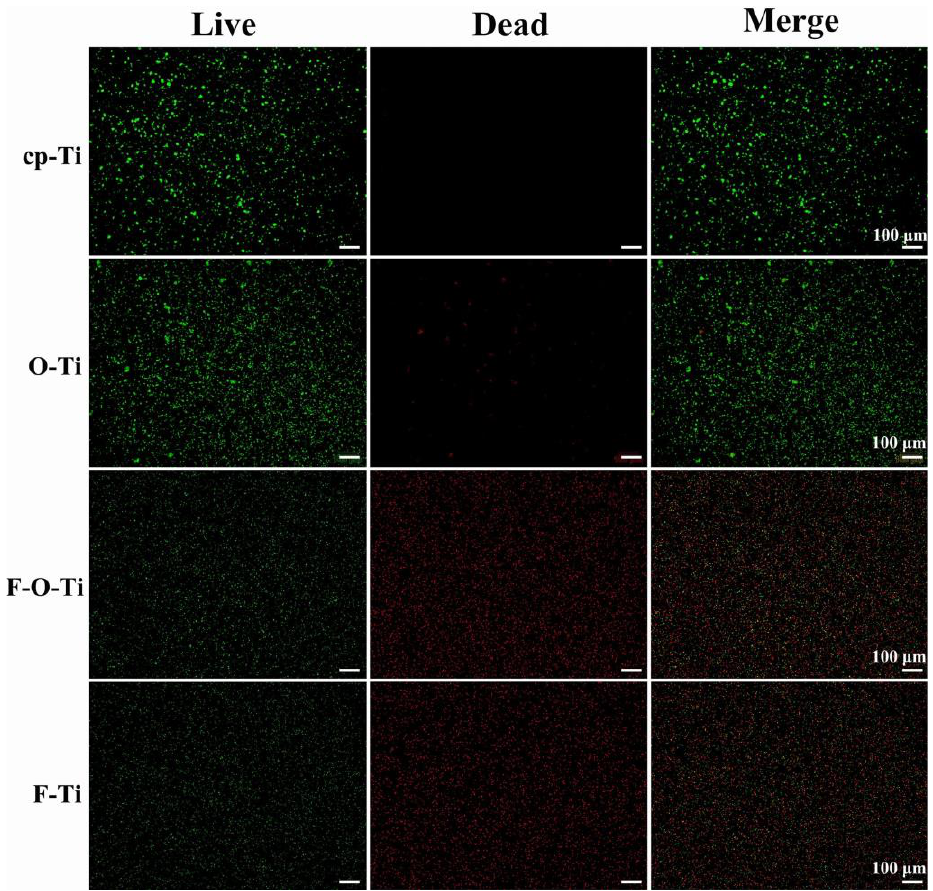
Figure 6. Live (green) and dead (red) staining of Staphylococcus aureus on different samples after culturing for 1 day. Adapted with permission from [136]. Copyright 2022, Elsevier.